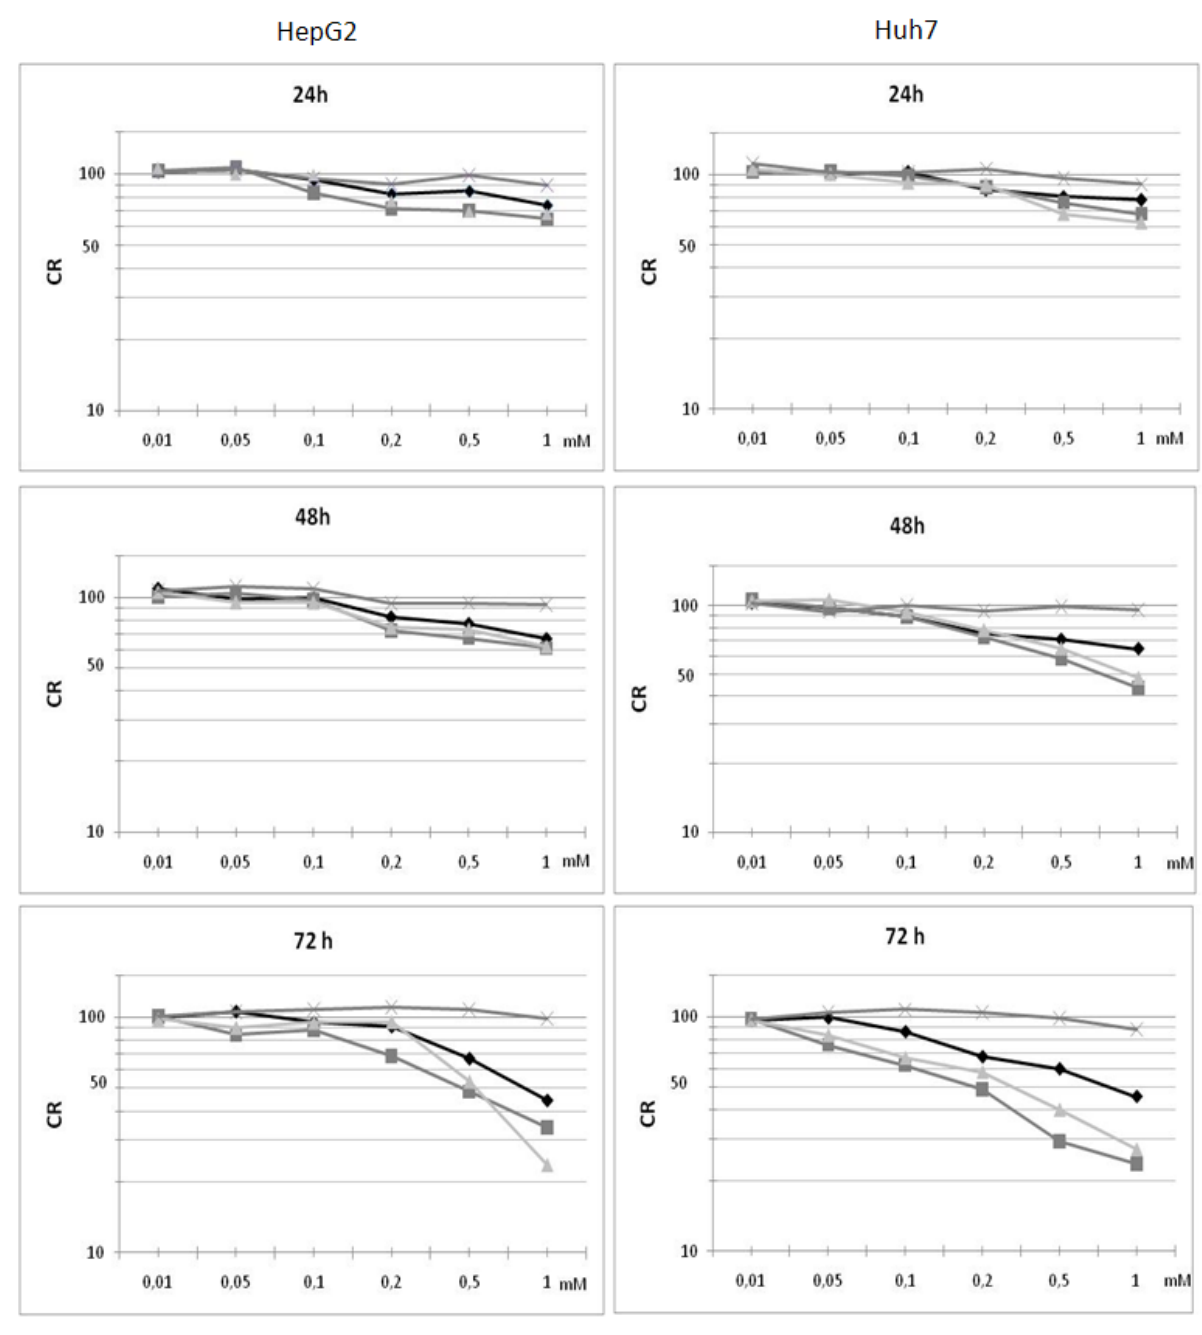
Figure 2. HepG2 and Huh7 cell lines growth curves in the absence and presence of lipoic acid, caffeic acid and 2-S-lipoyl-caffeic acid. On the x-axis is showed the different molecular concentrations (mM), on the y-axis cell growth rate